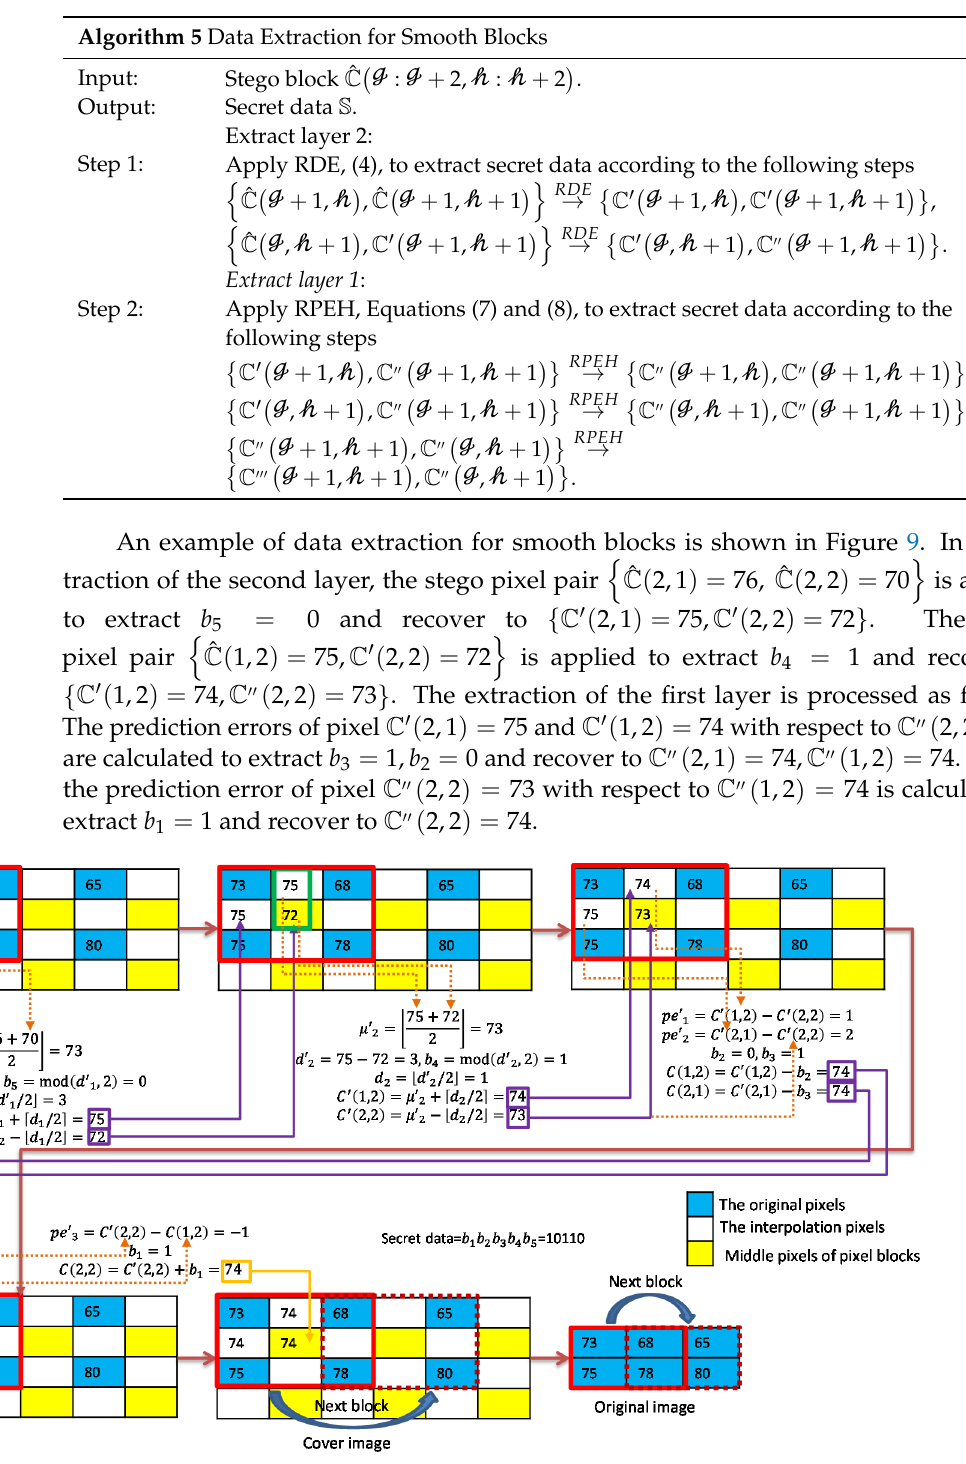
Figure 9. Example of data extraction for smooth blocks.